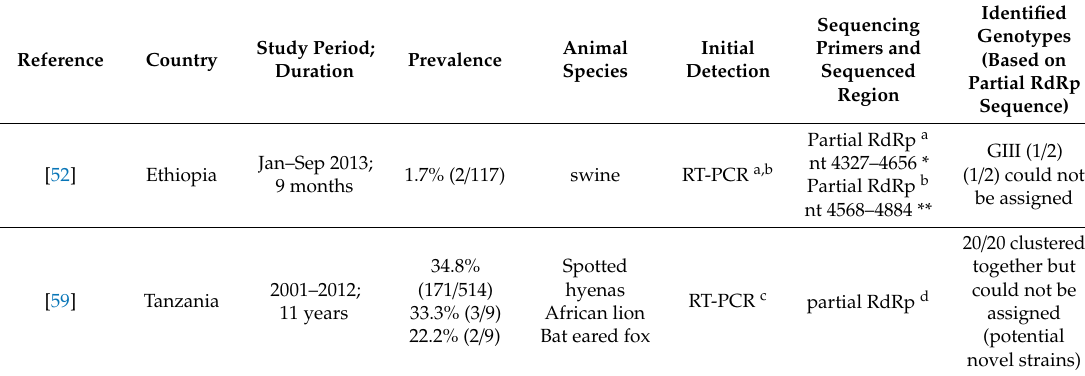
Table 4. Summary of reported studies on animal sapovirus in